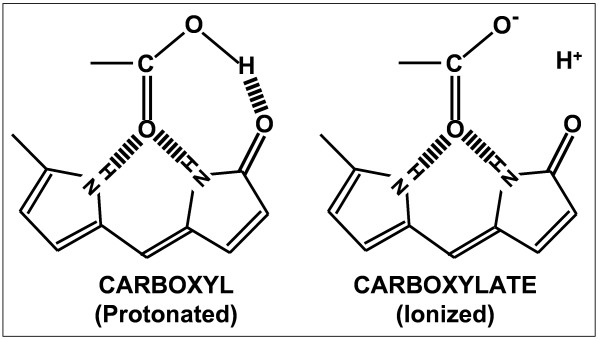
Two-dimensional representation of the structural environment of the carboxyl groups of unconjugated bilirubin. Left panel shows the three internal hydrogen bonds (||||||) that involve each -COOH group of unionized UCB diacid. All the donors and acceptors of the hydrogen bonds belong to the UCB molecule. With ionization of the -CO-OH group (right panel), the H-bond involving the -OH group is lost, but the two H-bonds remain that involve the carbonyl group of the carboxylate anion (-CO-O-).